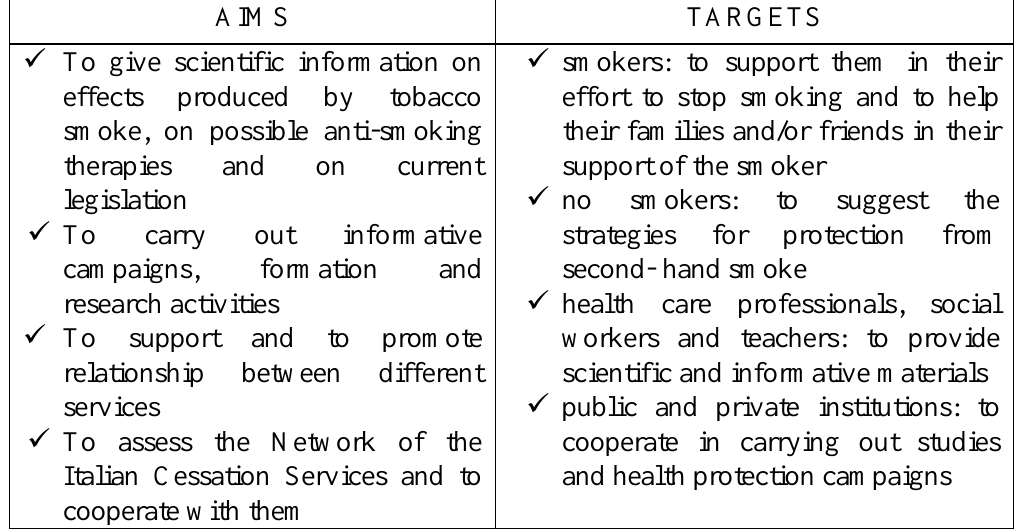
Table 1. Italian Antismoking Helpline aims and